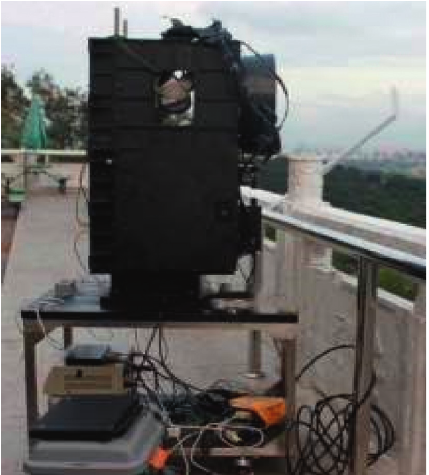
Figure 2: Large-load motor turntable.